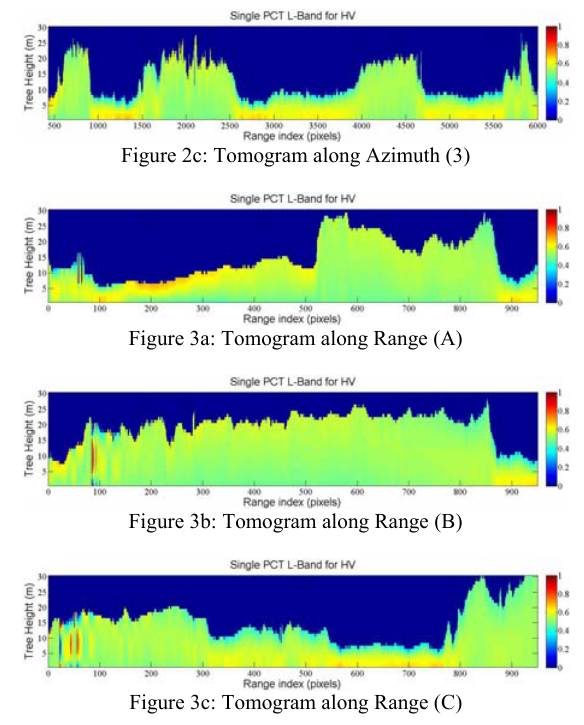
Figure 3c: Tomogram along Range